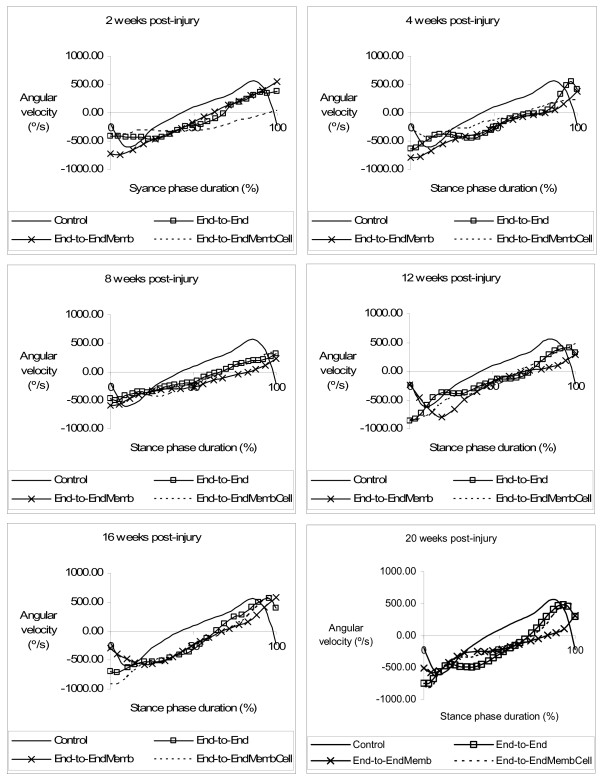
Kinematics plots in the sagittal plane for the angular velocity (°/s) of the ankle as it moves through the stance phase, during the healing period of 20 weeks. The mean of each group is plotted.